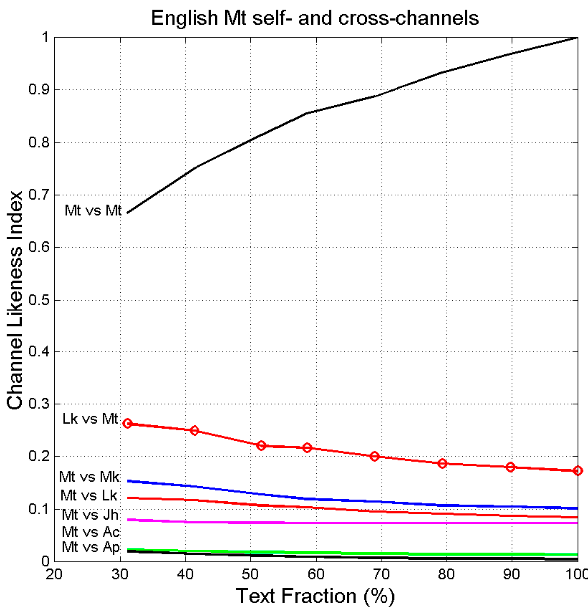
Figure 17. I L vs. text fraction in Matthew self- and cross-channels, in English. In Mt vs. Lk cross-channel (solid red line) Matthew is compared to Luke; in the reverse channel Lk vs. Mt (solid red line with circles), Luke is compared to Matthew. g 1 ( y ) refers to Mt self ‐ channel.